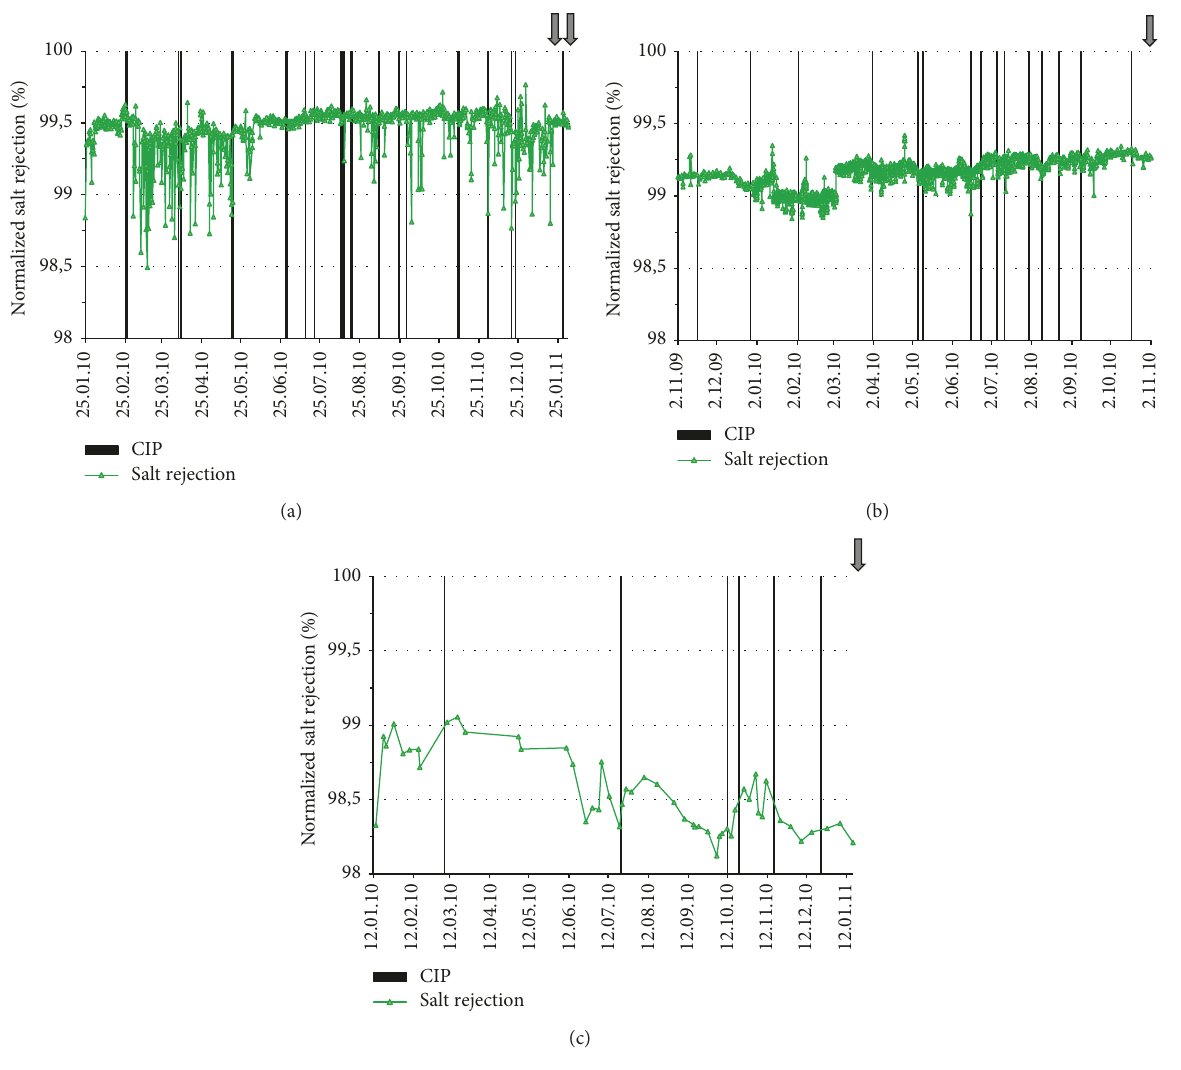
Figure 4: Membrane integrity as indicated by % salt rejection (= 100 – salt passage) for (a) plant location I, (b) plant location II, and (c) plant location III. Vertical lines indicate CIP. Time points of membrane autopsies are indicated with dark grey arrows. installations permanently operate suboptimally (Figures